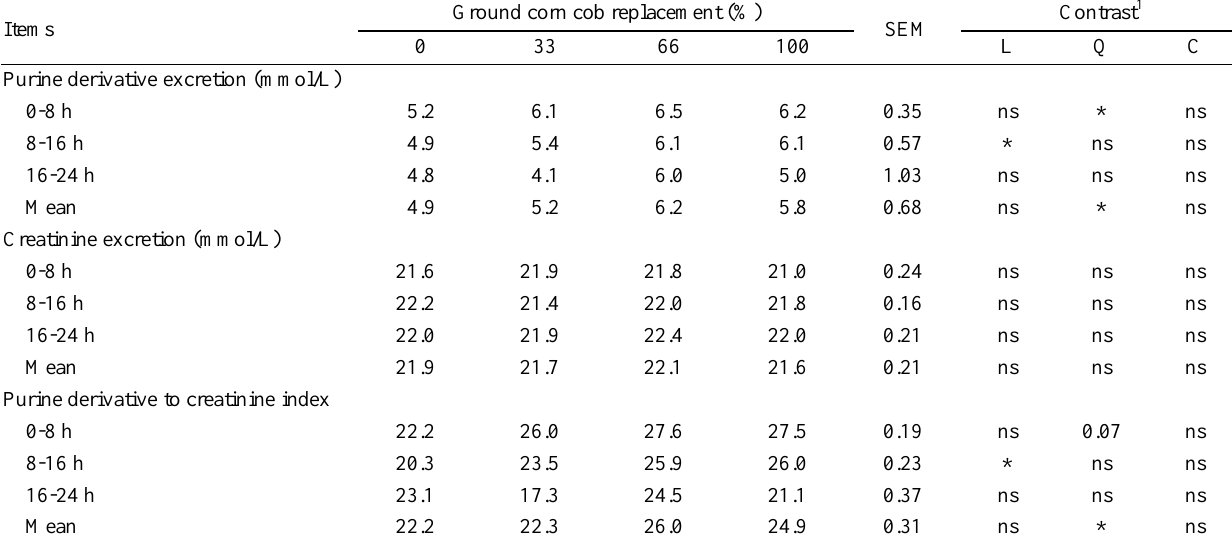
Table 5. Effect of ground corn cob replacement on purine derivatives and creatinine excretion in swamp buffalo Items